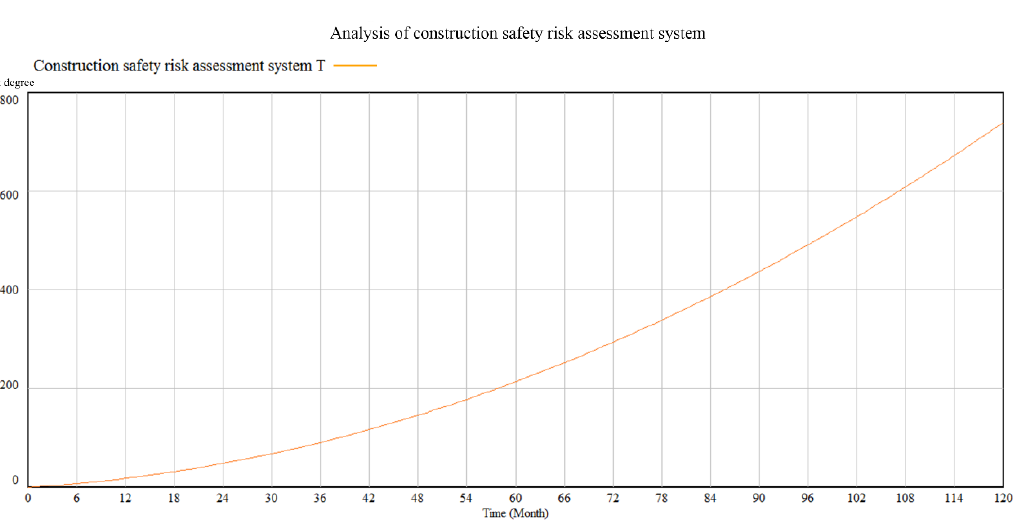
Figure 5. Analy-sis of risk changes in different stages of the construction site. It can be seen from the above contents that pre-construction has the most significant influence. The factory quality of prefabricated components has the most significant impact on construction safety, then during-construction and after-construction, which shows that the production quality of the components and parts of the prefabricated building are the first step to ensure safety. Factory preparation is the most significant influencing factor. It also illustrates the technology of prefabricated buildings in China; enough attention should be paid to the deficiencies in the aspects. 4. Case Analysis 4.1. Basic Information of a Prefabricated Construction Project There are three prefabricated building projects within the complex residential con- struction in Changle City, Fujian Province, with a floor area of 40,000 m 2 . Among them, #2 is 34 floors, and the building height is 95.62 m; #20 and #21 buildings are 34 floors, and